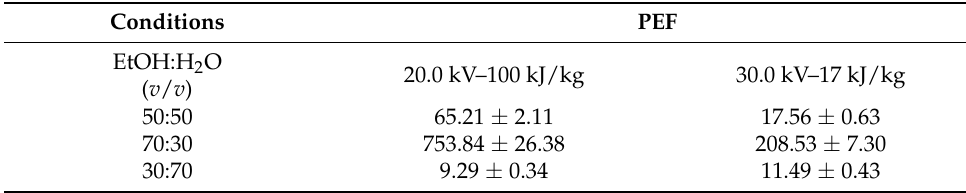
Table 2. Phloridzin content ( µ g/g fresh AP, mean ± SD n = 2) obtained with PEF.